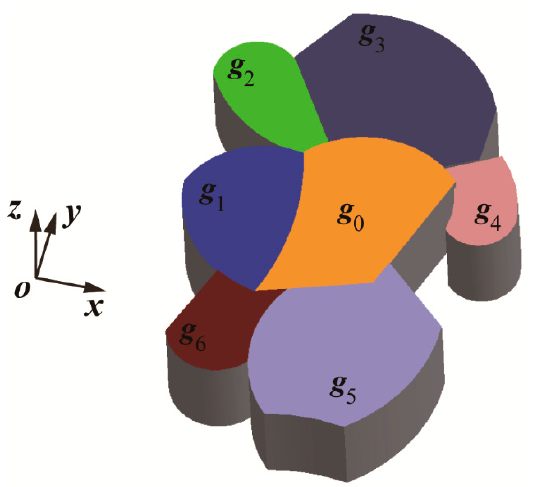
Figure 4. Virtual reconstruction map of local nonlinear lengths of grain boundary interface layers.